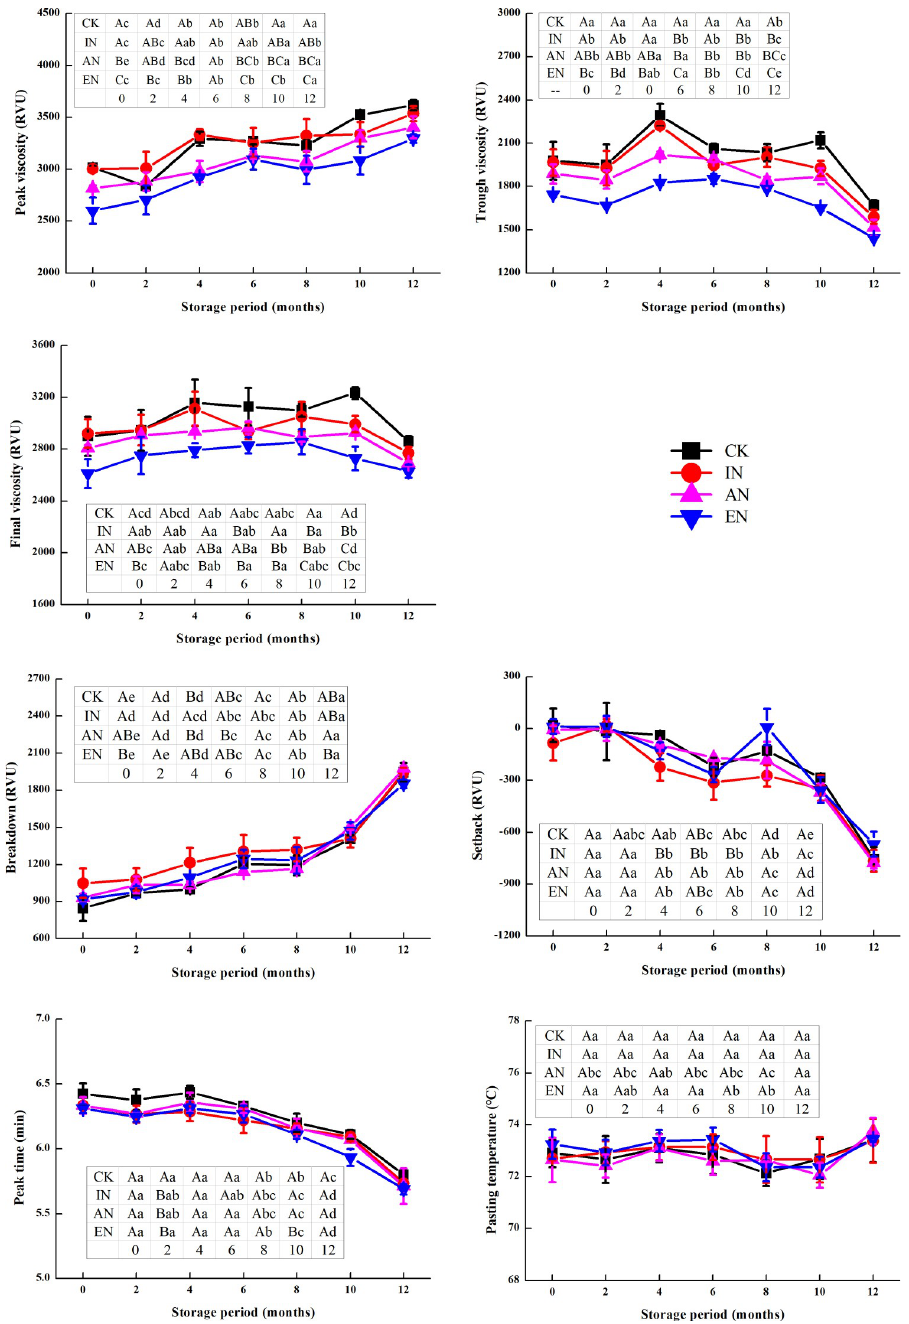
Fig 6. The changes in pasting characteristics of rice during storage, after different nitrogen application rates. CK, control group (0 kg N/ha); IN, insufficient nitrogen (160 kg N/ha); AN, adequate nitrogen (260 kg N/ha); EN, excessive nitrogen (420 kg N/ha). Data (mean ± standard deviation, n = 9) with different letters are significantly different (p < 0.05). For each parameter, different lowercase letters in the same rows differ significantly as a function of storage time. Different uppercase letters in the column denote significant differences as a function of different nitrogen application rates.